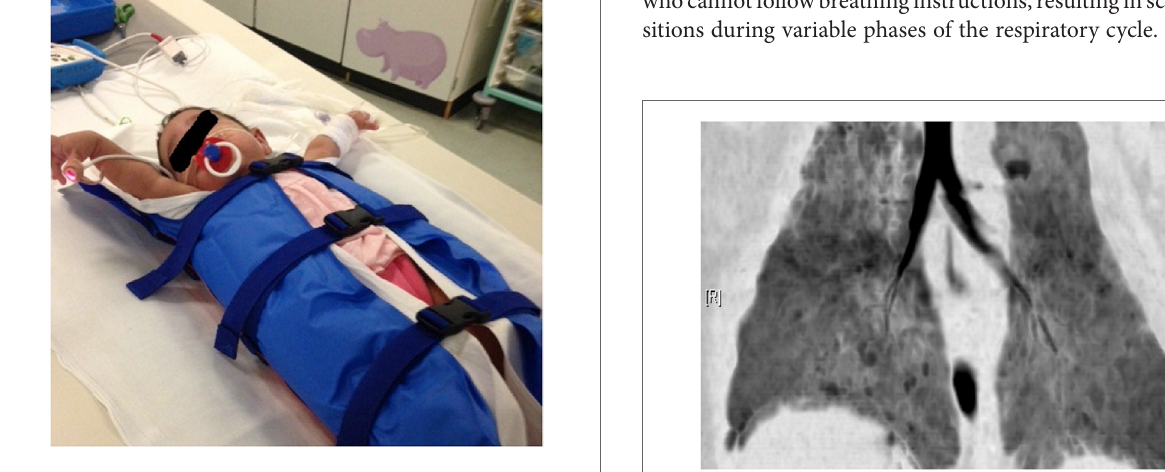
FigURe 4 | Minimum intensity projection CT reconstruction demonstrating airway morphology and regions of heterogeneous (mosaic) attenuation in a child with bronchopulmonary